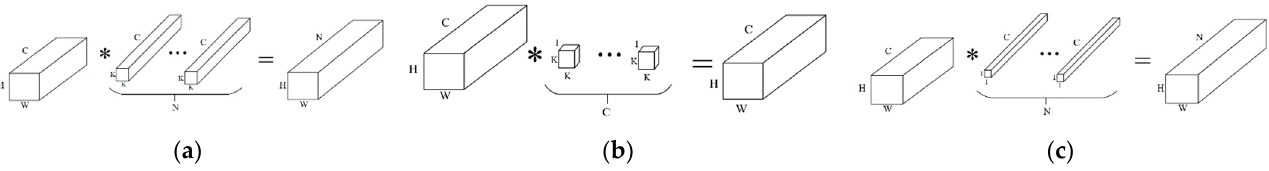
Figure 3. ( a ) Standard convolution filters, ( b ) depth-wise convolution filters, ( c ) point-wise convolution filters. In the figure, K × K is the kernel size; C is the number of input channels; H × W is the size of spatial information; and N is the number of output channels; * is a convolution operation.